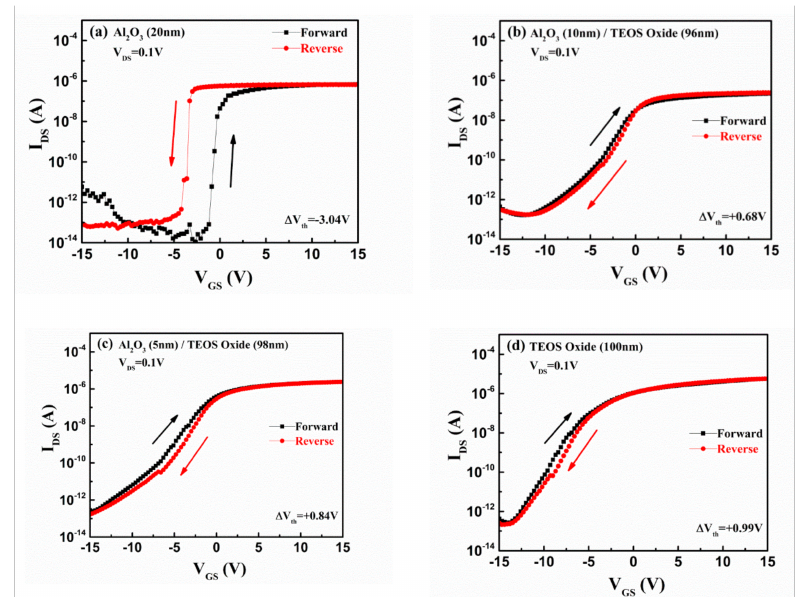
Figure 4. Hysteresis characteristics of a-IGZO TFTs with the respective ( a ) Al 2 O 3 (20 nm), ( b ) Al 2 O 3 (10 nm) / TEOS oxide (96 nm), ( c ) Al 2 O 3 (5 nm) / TEOS oxide (98 nm) and ( d ) TEOS oxide (100 nm) gate